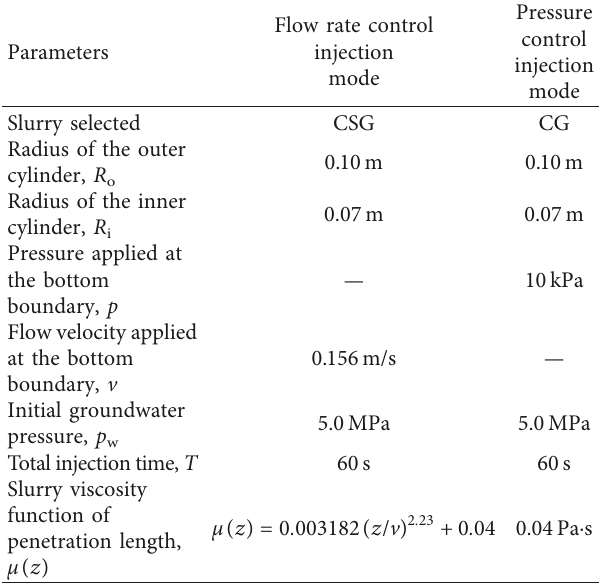
Table 2: The numerical parameters used in the finite element